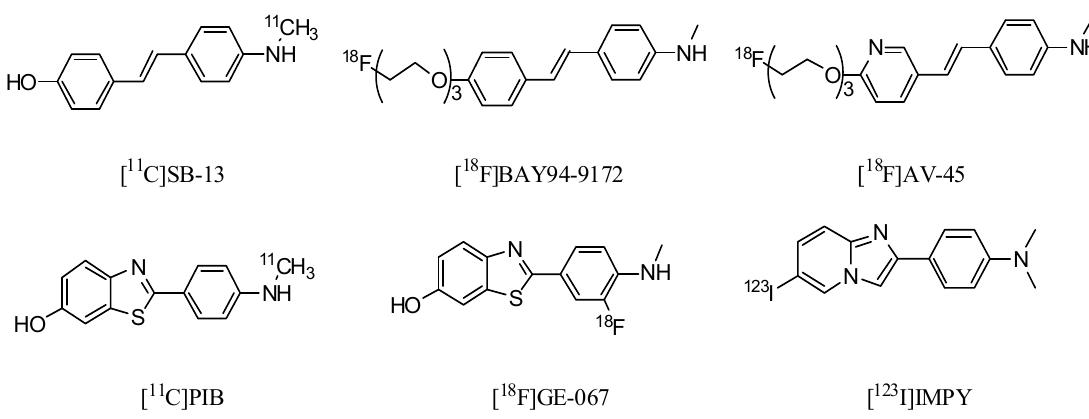
Figure 1. Chemical structures of A β imaging probes for clinical